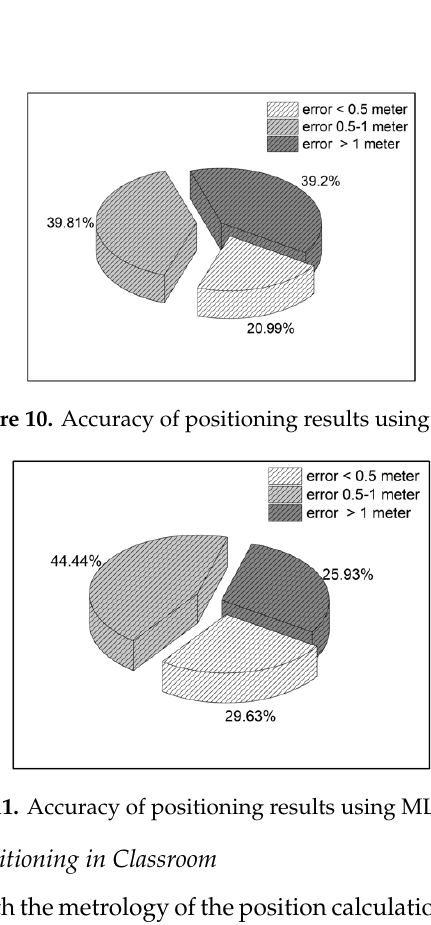
Table 1. Deviation in position calculations of chairs in the room type